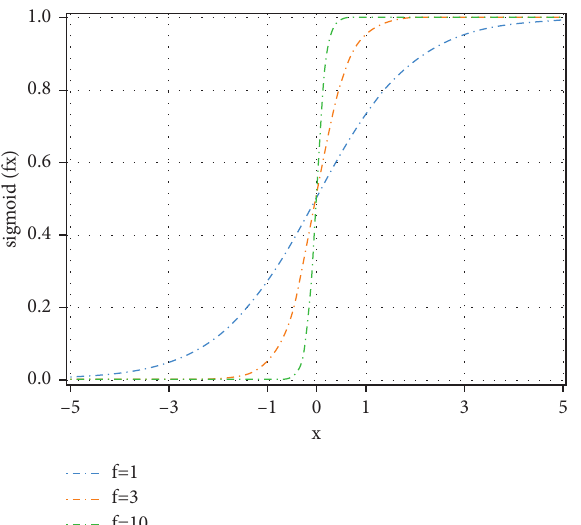
Figure 2: Sigmoid function with different slope f .